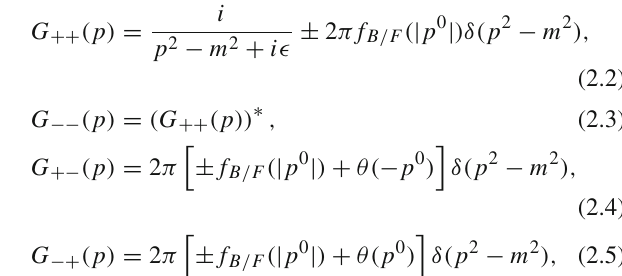
Fig. 1 Circling rules in doubled interaction vertices specified by different thermal indices ± . Here L Y can be either the Yukawa Lagrangian of the SM extended by a neutrino term or of the neutrinophilic two-Higgs-doublet model (2HDM), to be discussed